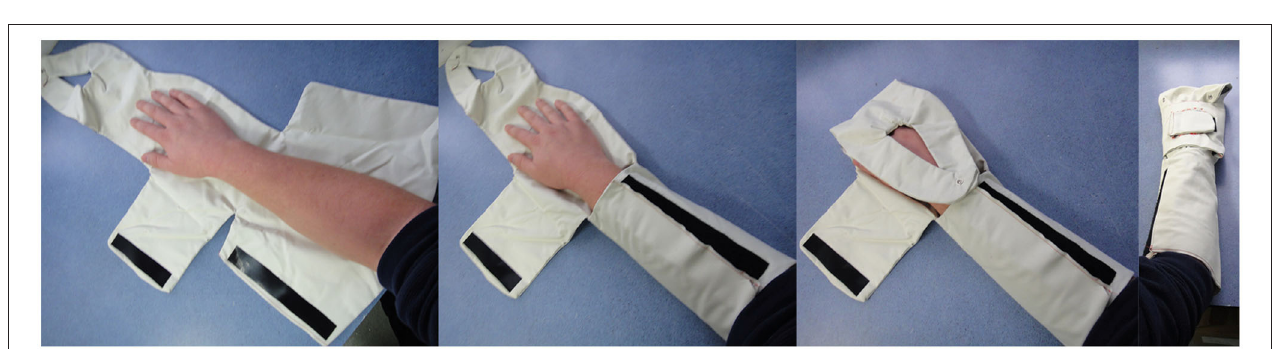
FIGURE 7 | Cross-sectional analysis of the limb wrap materials and components.